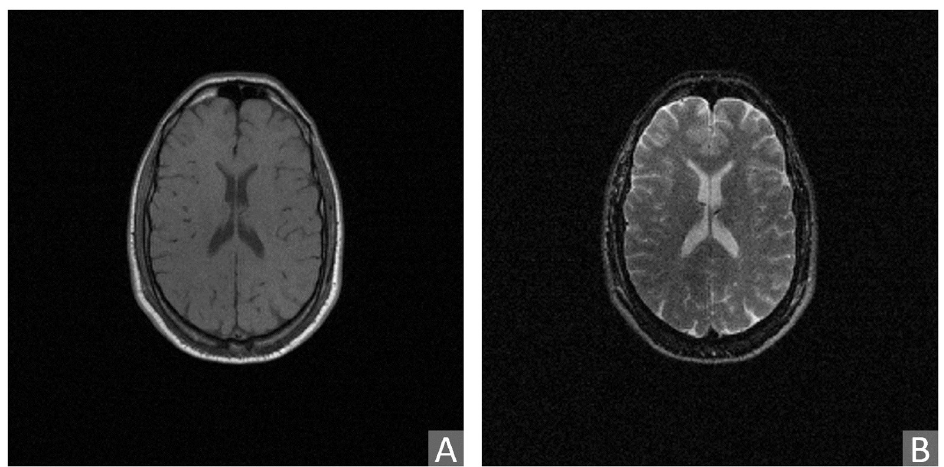
Fig 3. Example of pair of (slices of) original 3D radiological images from the RIRE dataset acquired by different modalities considered in this study. (A) Modality A: T1 MR image, (B) modality B: T2 MR image.